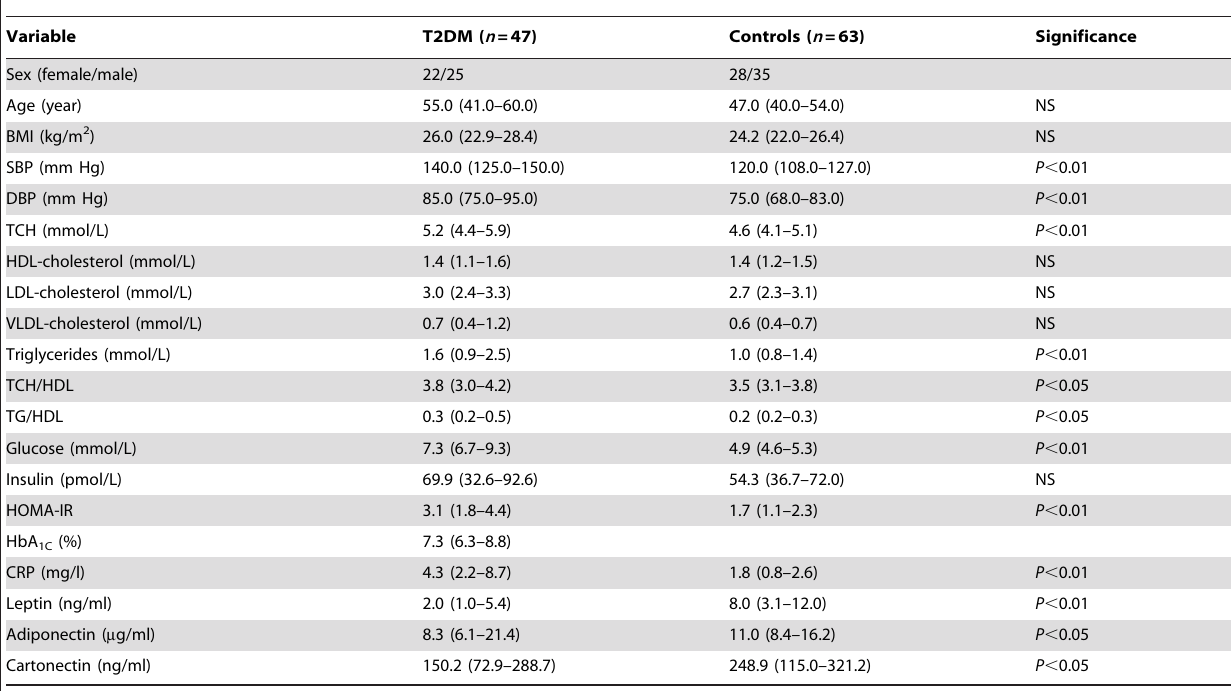
Table 1. Clinical, hormonal and metabolic features of study subjects.